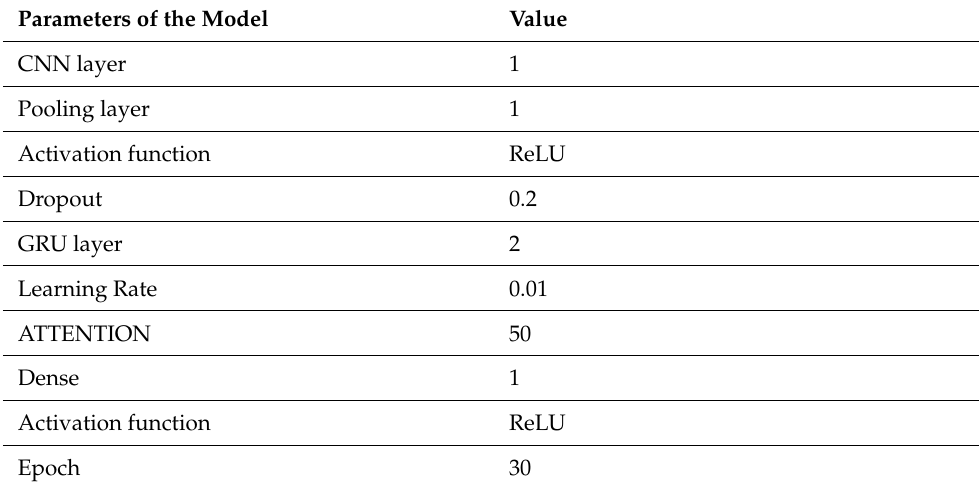
Table 3. Australian Load Output Dataset Model Parameters.